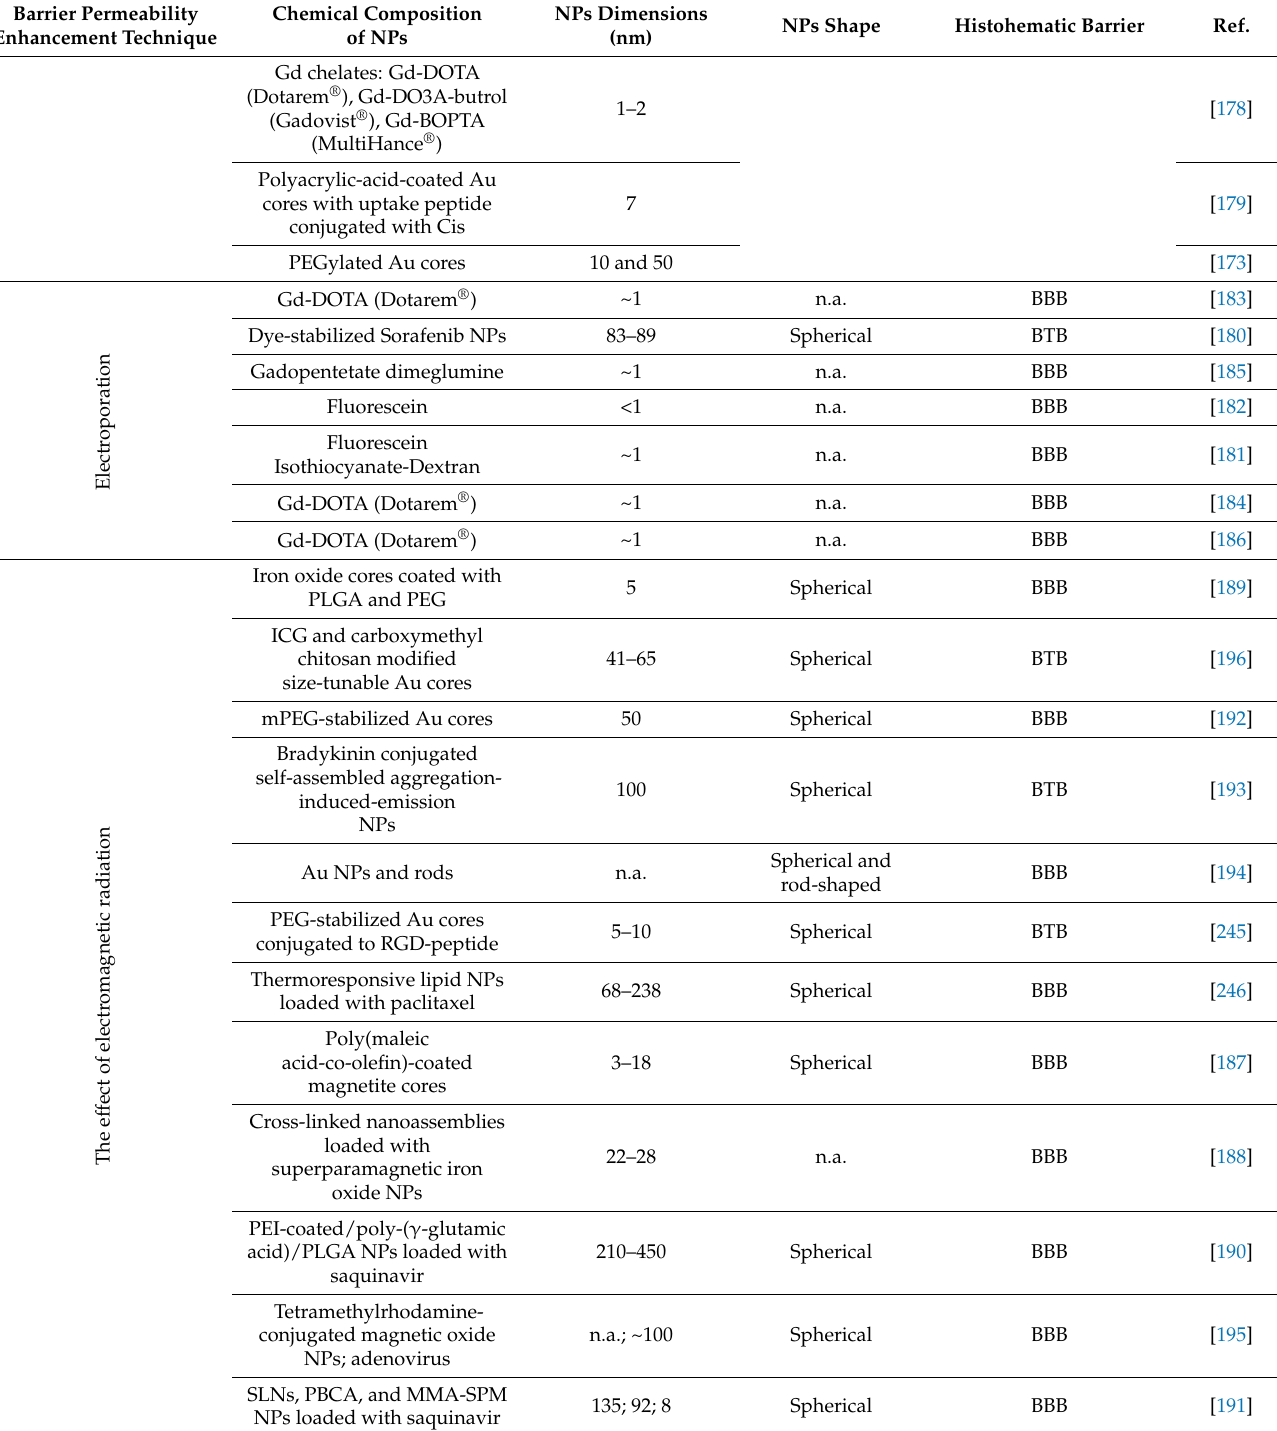
Barrier Permeability Enhancement